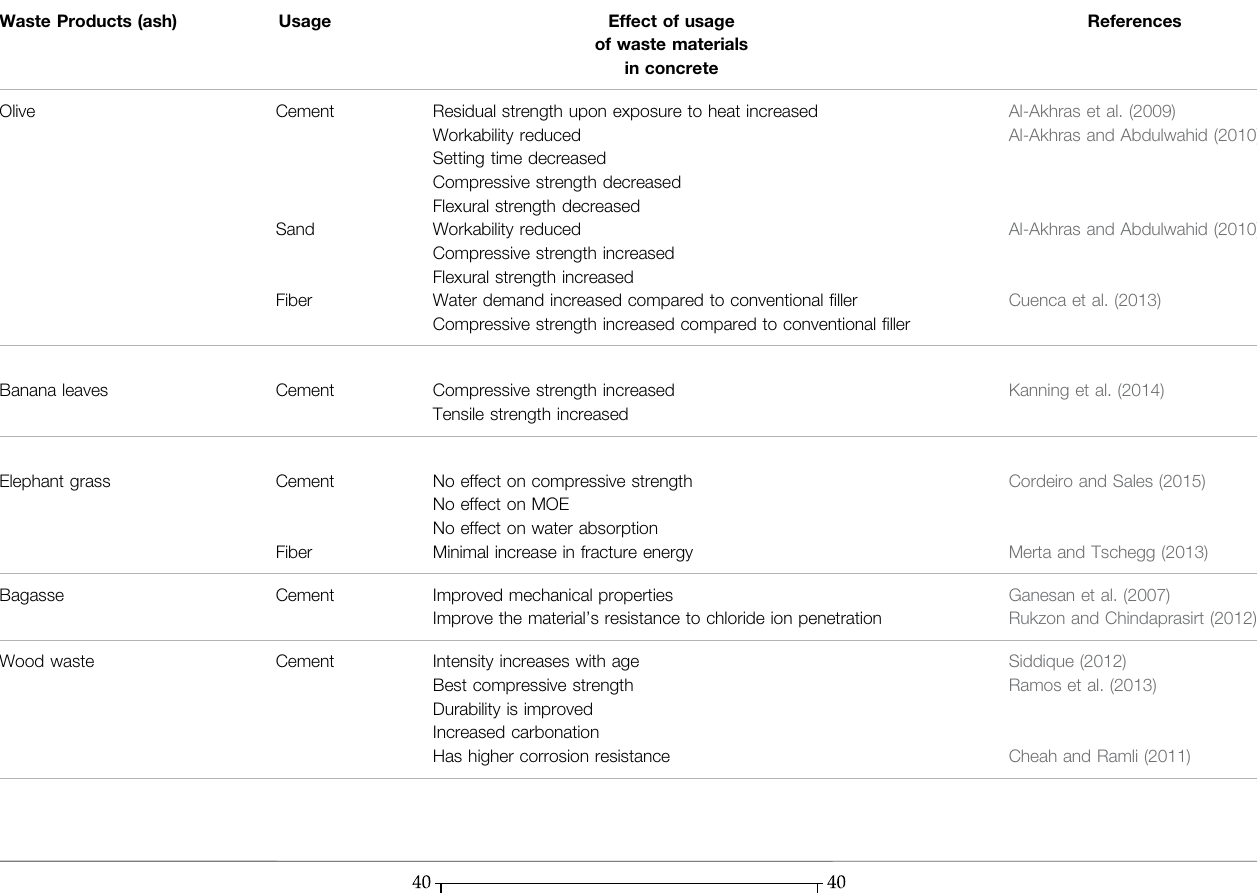
TABLE 3 | Usage of agricultural waste ash in concrete.